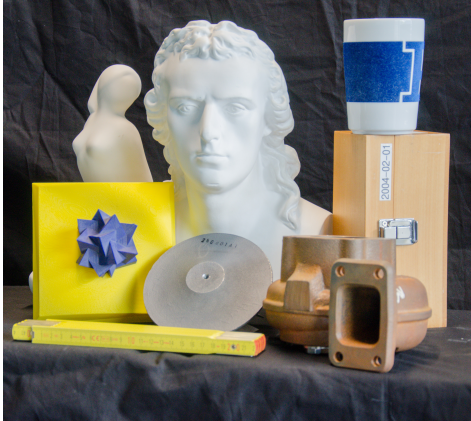
Figure 7. Photograph of the test